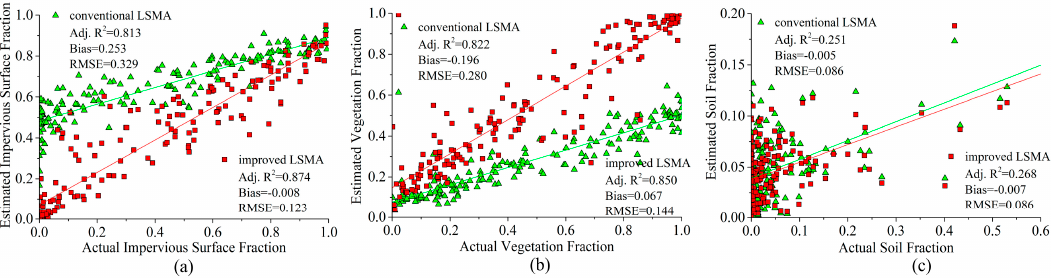
Figure 8. Scatter plots of accuracy assessment results: ( a ) impervious surface; ( b ) vegetation; and ( c ) soil. RMSE: root-mean-square error.